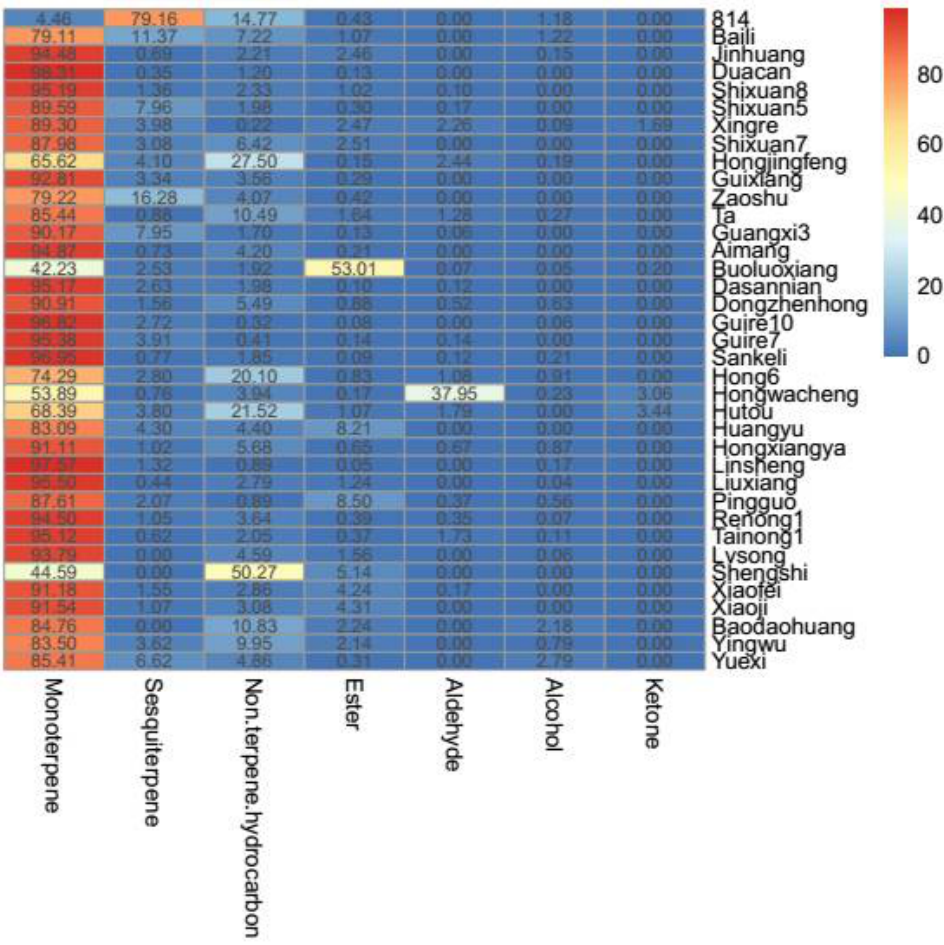
Figure 2. Relative abundance (%) and heatmap of different classes of volatile compounds in 37 mango cultivars.